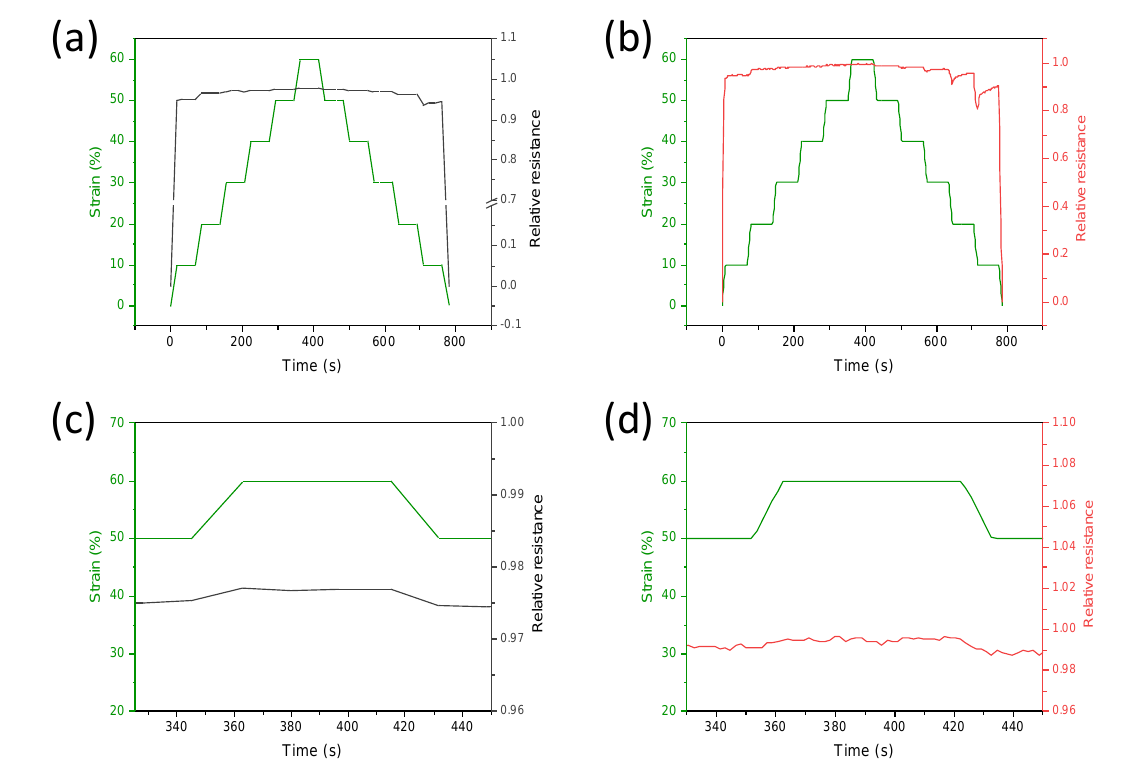
Figure 7. Time-resolved current variation at different strains measured on PDMS/CNTs long (gray curve), ( a ) and PDMS/CNTs short (red curve). ( b ) Sponges subjected to loading/unloading steps from 0 to 60%. In ( c , d ), the enlargement at 60% strain is reported.